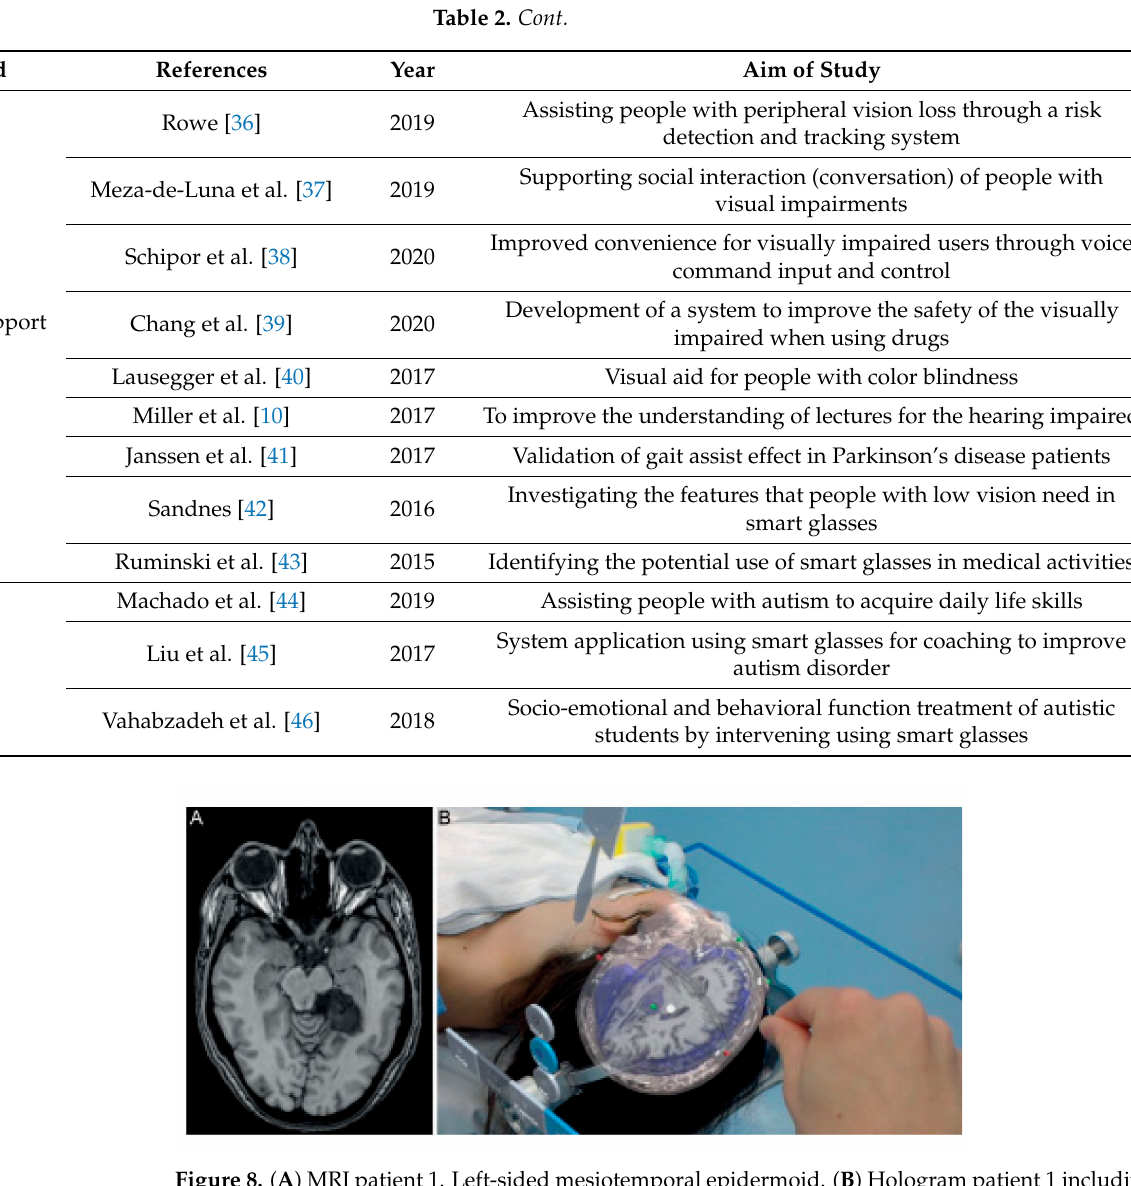
Figure 8. ( A ) MRI patient 1. Left-sided mesiotemporal epidermoid. ( B ) Hologram patient 1 including MRI